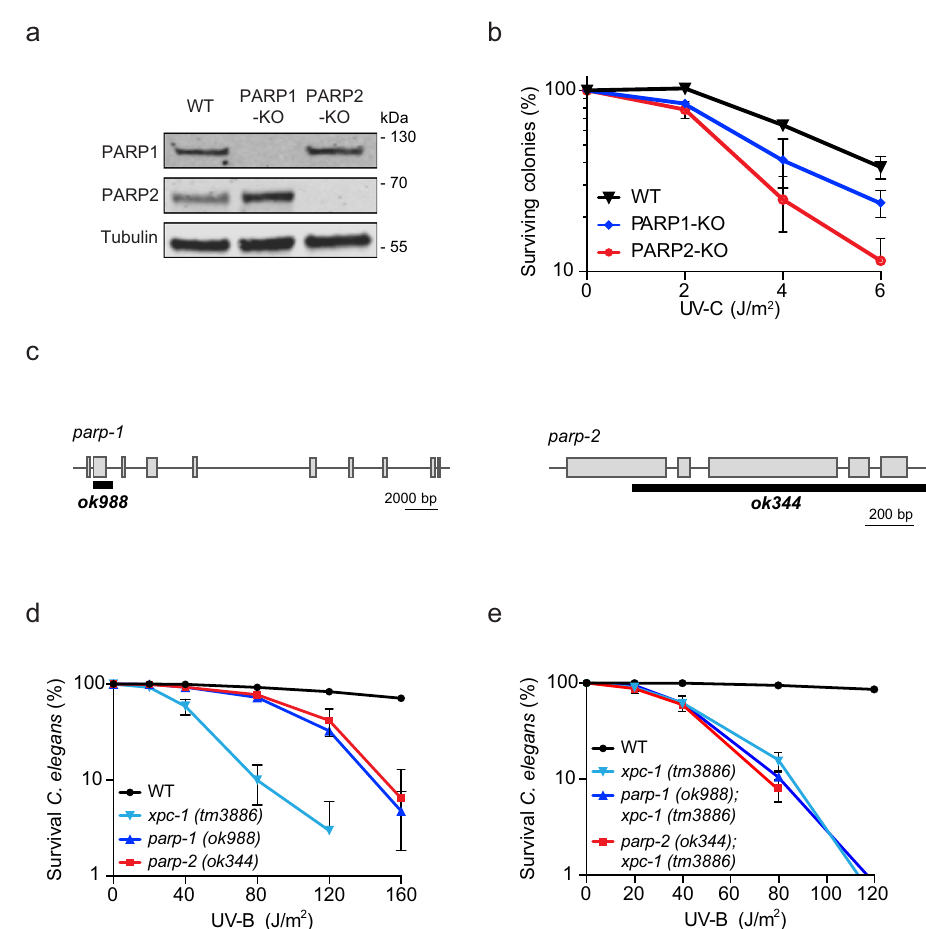
Fig. 6 PARP1 and PARP2 impact the repair of CPD lesions. a Western blot of U2OS WT, PARP1-KO and PARP2-KO cells. b Clonogenic survival assays of U2OS WT, PARP1-KO, and PARP2-KO cells upon UV-C irradiation. The data is depicted as mean + S.E.M. from n = 4 independent experiments, except for PARP1-KO for which n = 3. c Representation of the deletions in the C. elegans parp-1 (ok988) and parp-2 (ok344) strains. d Germ cell and embryo UV survival assays of PARP1-de fi cient parp-1(ok988) and PARP2-de fi cient parp-2(ok344) C. elegans . e Germ cell and embryo UV survival assays of XPC- de fi cient xpc-1 (tm3886), XPC and PARP1 double de fi cient (ok988; tm3886), or XPC and PARP2 double de fi cient (ok344; tm3886) C. elegans . d , e The data are depicted as mean + S.E.M. from three independent